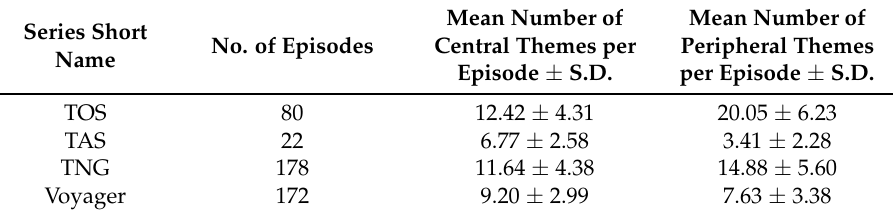
Table 3. Thematically annotated Star Trek television episode summary statistics by series. Mean Number Series Short No. of Episodes Name